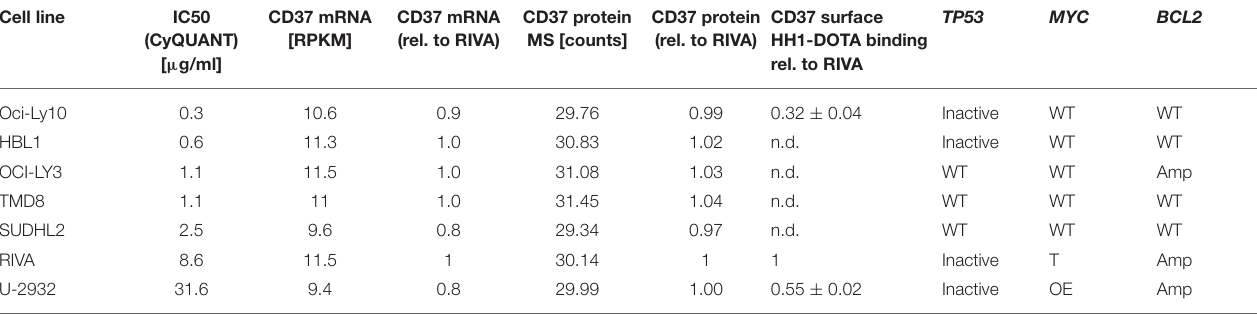
TABLE 1 | Characteristics of ABC-DLBCL cell lines. Cell